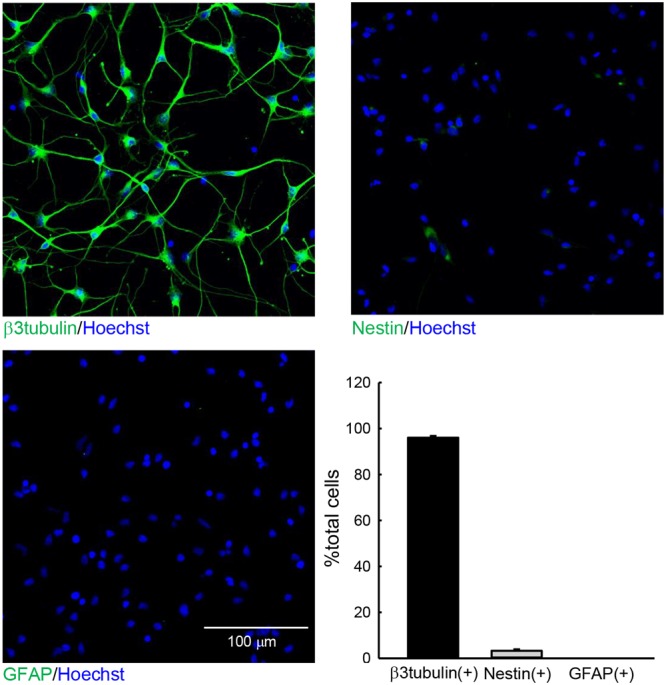
The cells used in this study. hiPSC-neurons were immunostained with anti-β3 tubulin (top left), anti-Nestin (top right), or anti-GFAP (bottom left) antibodies and subsequently subjected to Hoechst staining at 3 DIV. The numbers of total cells and cells that were positive for the respective differentiation markers in a 300 μm × 300 μm area were counted. The ratios of cells that were positive for respective markers are presented as the % total cells (bottom right). N = 6. The hiPSC-neuron sample used in study contained mostly β3 tubulin+ neurons.